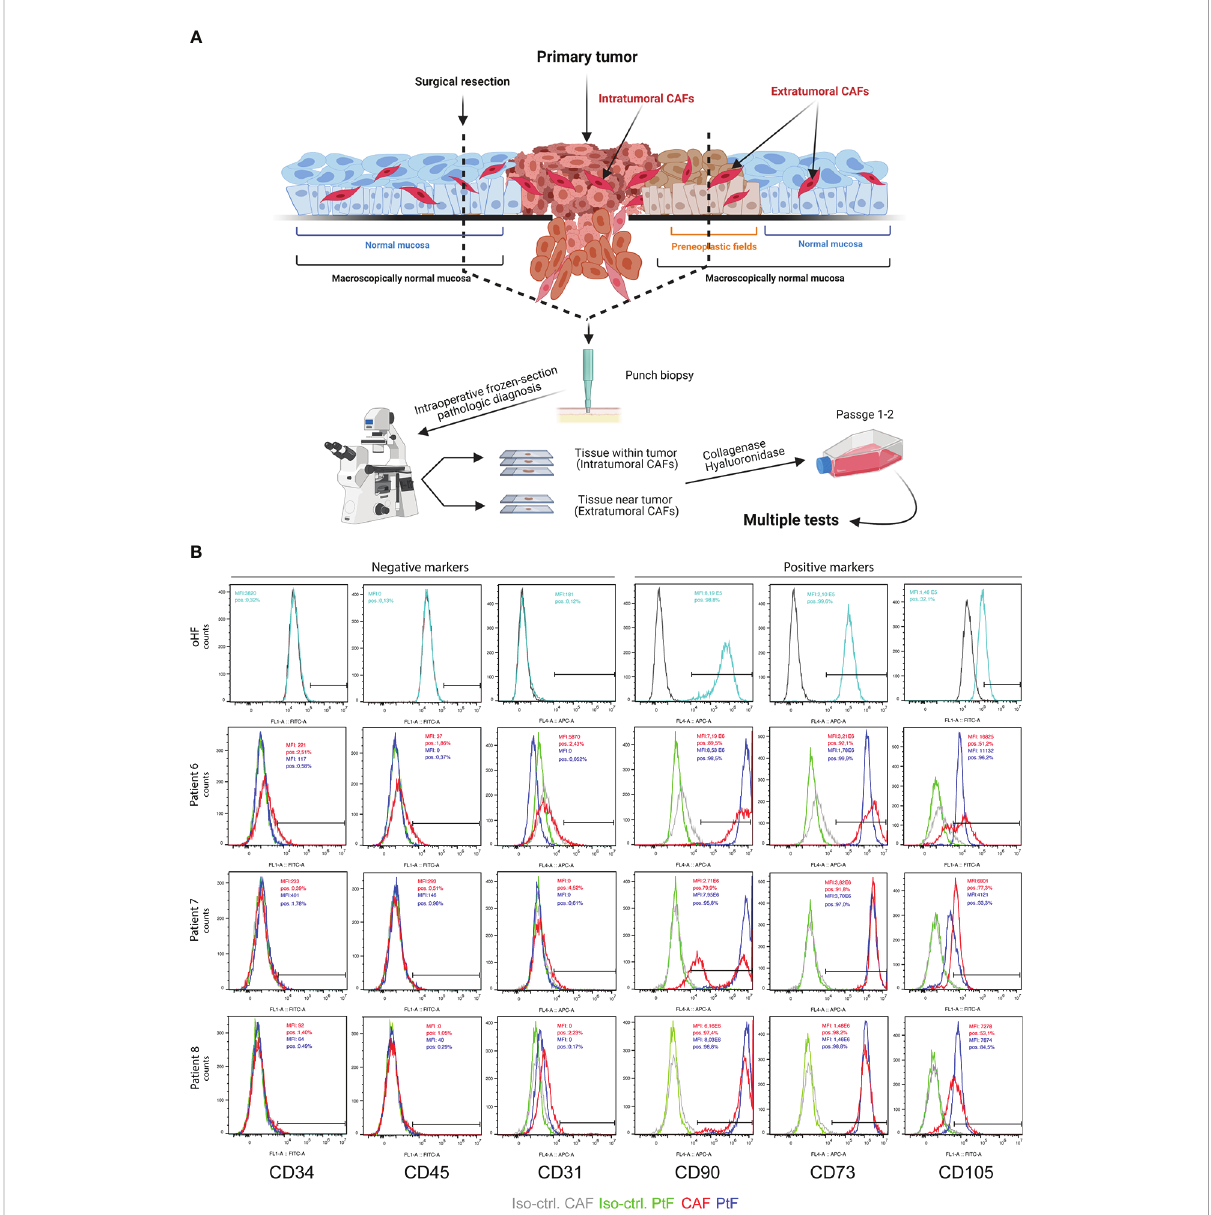
FIGURE 1 Establishment of PtFs and CAFs from OPSCC patient samples. (A) Schematic representation of the work fl ow to establish peri- and intratumoral CAFs (PtFs and CAFs, respectively). Punch biopsies were taken from areas of microscopically normal mucosa and primary OPSCC. After pathological diagnosis on frozen tissue sections during surgery, single cells were generated from punch biopsies and PtFs and CAFs were isolated. (B) PtFs and CAFs in passages 1-2 and hOFs were stained for the expression of fi broblast markers (CD90, CD73 and CD105) and markers for leukocytes, hematopoietic cells, and endothelial cells (CD45, CD34 and CD31, respectively). Expression levels were assessed by fl ow cytometry and percentage of positive cells standardized for cognate isotype controls are shown in the top right corner of the histogram for both PtFs (blue) and CAFs (red). The same markers were assessed in human oral fi broblasts (hOF) and are shown in the upper panels. Figure 1A was generated using BioRender und publication license number